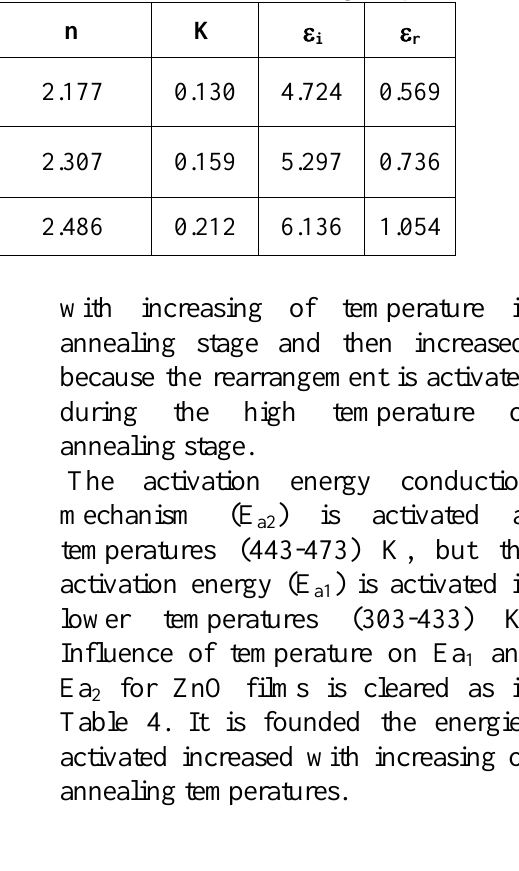
Fig.4: (αhv) 2 as a function of hv for ZnO thin films at different annealing temperatures (as deposited, 373, 473) K. Table 3: Optical properties parameters of ZnO films at different annealing